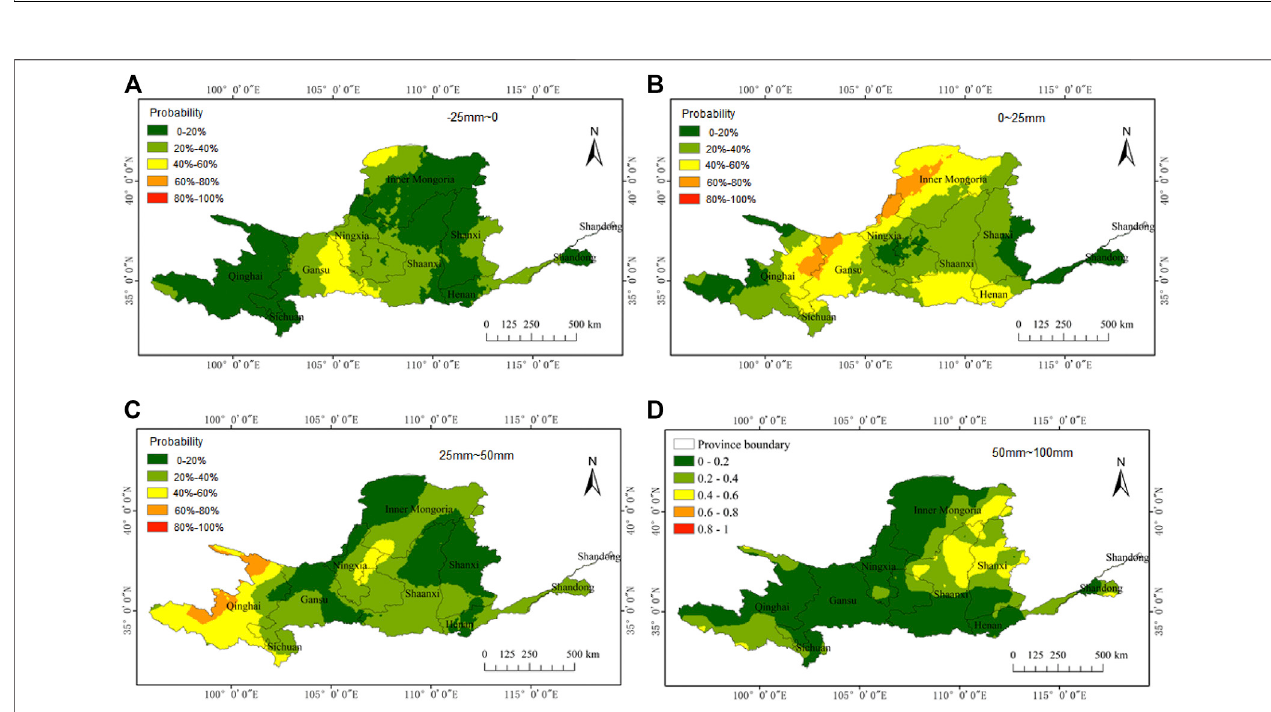
FIGURE 13 | Annual average precipitation probability projection in the future period of 2021 – 2050. (A – D) represents four variations of (A) − 25 to 0 mm, (B) 0 to 25 mm, (C) 25 to 50 mm, (D) 50 to 100 mm.